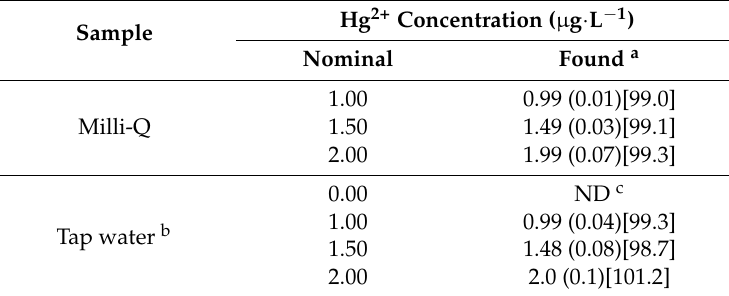
Table 3. Recovery study of Hg 2+ in spiked water samples.